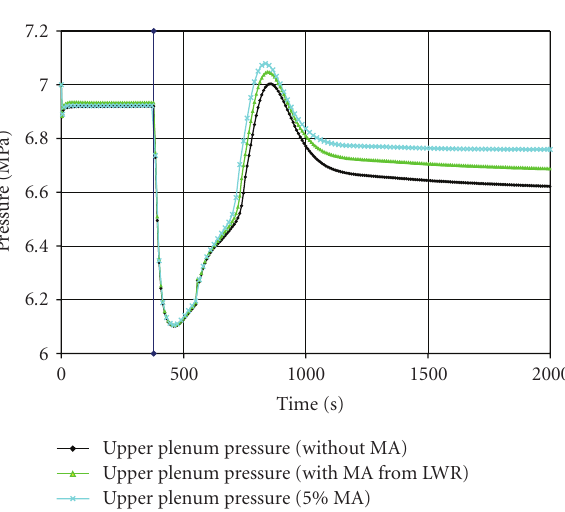
Figure 6: Core average exit temperature.